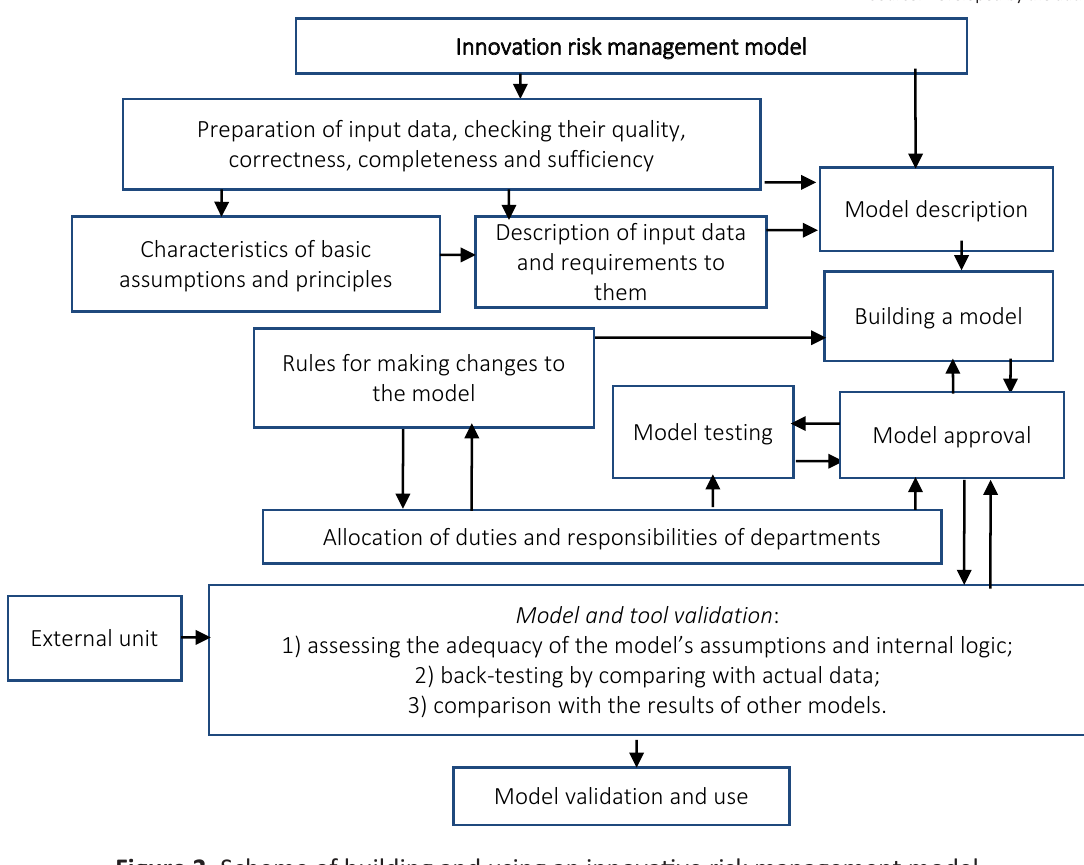
Figure 2. Scheme of building and using an innovative risk management